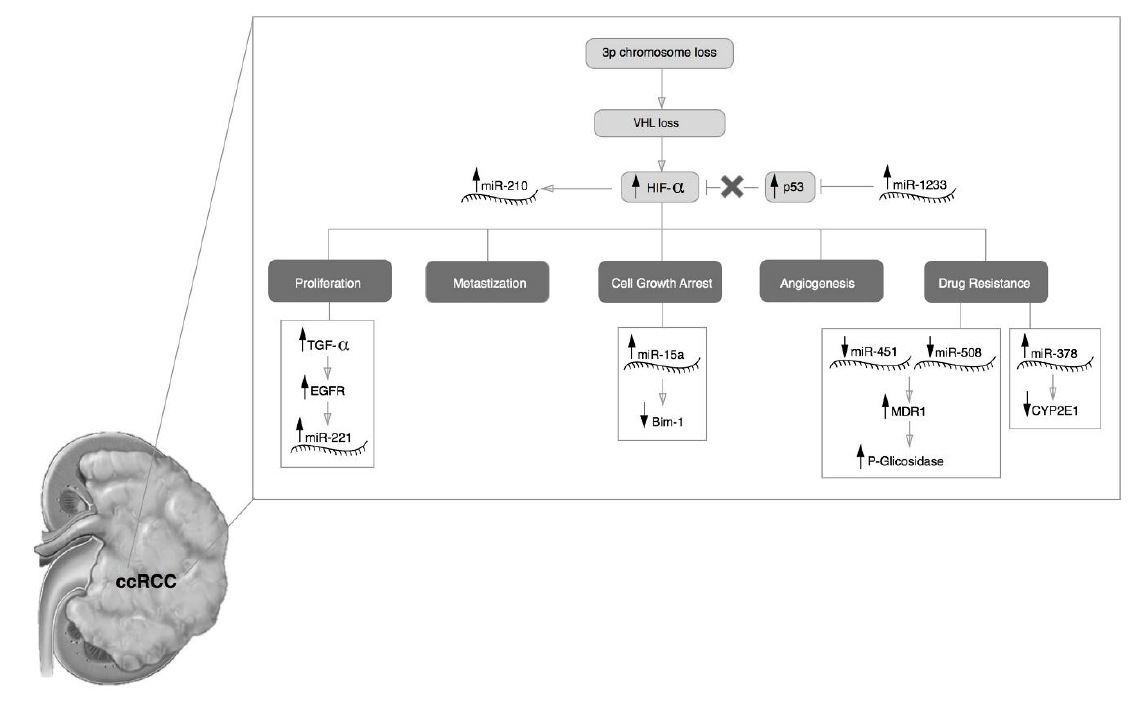
Figure 3. VHL and miRNA . Proposed mechanistic model for the role of miR-210, miR-1233, miR-221, miR-15a, miR-451, miR-508-3p, miR-378 during the ccRCC